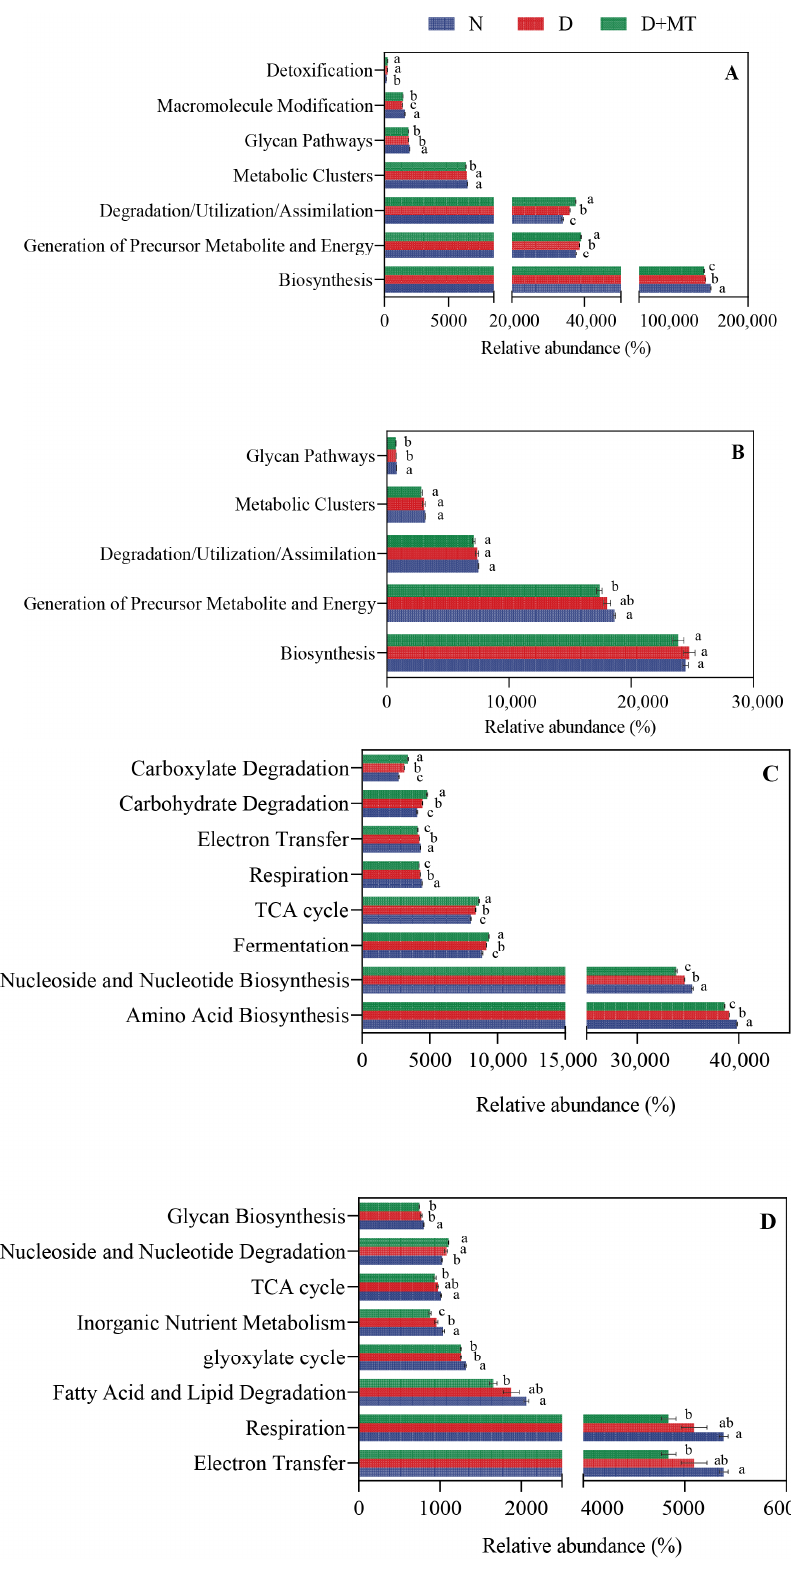
Figure 7. Functional abundance in bacterial and fungal communities at level 1 ( A , B ) and level 2 ( C , D ) under the combination of melatonin treatment and drought stress based on PICRUSt2. Data are reported as mean ± SE ( n = 4). Different small letters indicate significant differences at the p < 0.05 level. N, normal control; D, drought stress; D+MT, melatonin + drought stress.